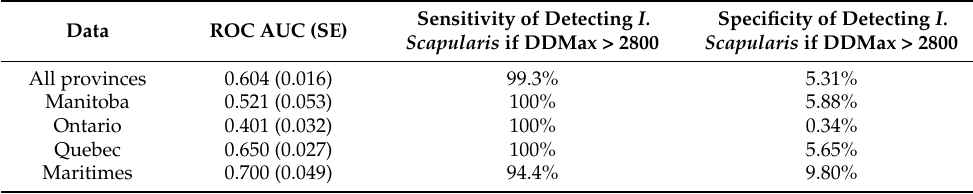
Table 3. Results of Receiver Operating Characteristic (ROC) analysis. Area under the ROC curve (AUC) values are shown alongside values for sensitivity and specificity of discrimination of Ixodes scapularis positive and negative with a maximum value for CSDF (DDMax) cut-off of 2800 degree- days >0 ◦ C. Sensitivity of Detecting I. Data ROC AUC (SE) Scapularis if DDMax >